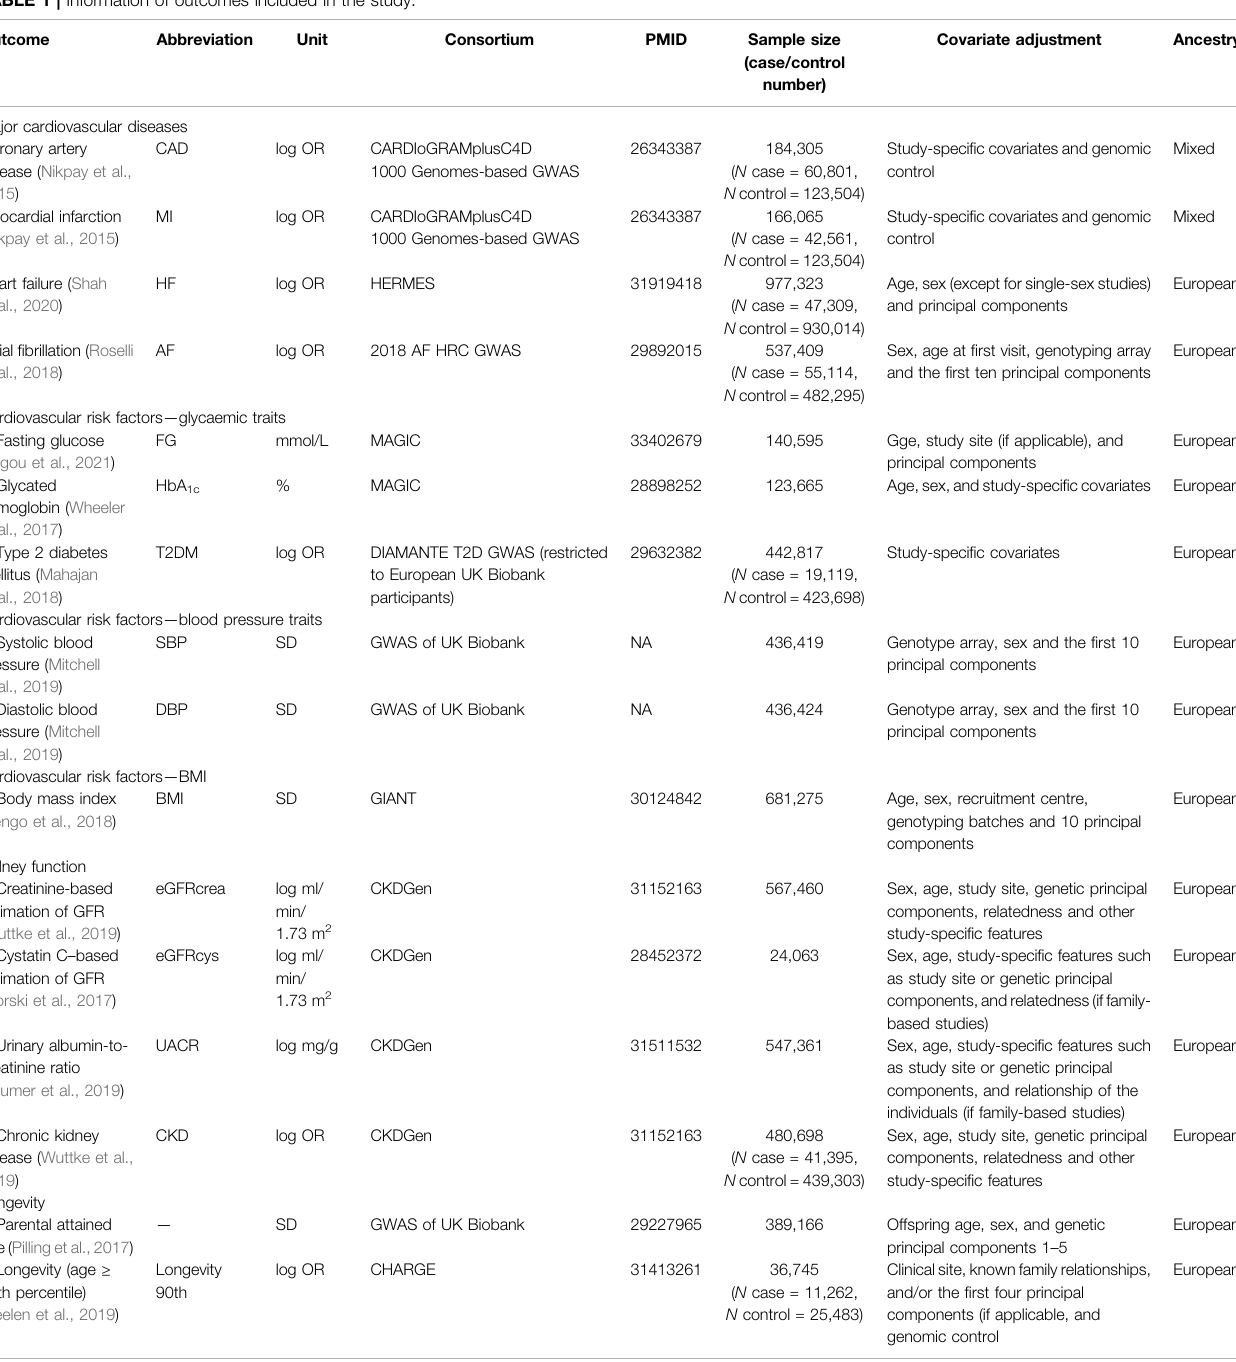
TABLE 1 | Information of outcomes included in the